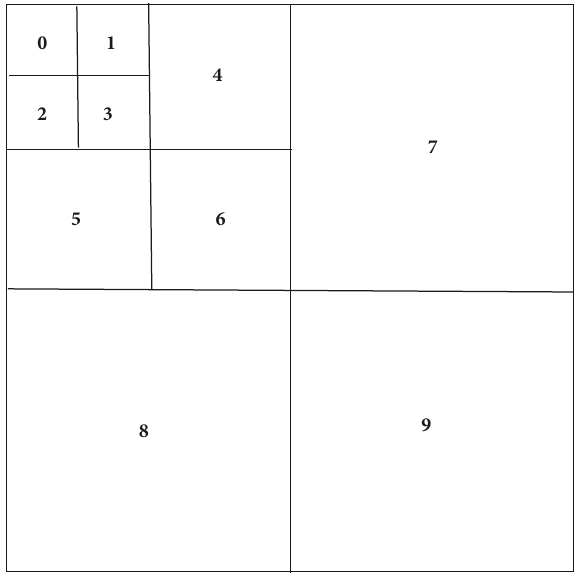
Figure 2: Ten subbands of Krawtchouk moments for one image block of 8 × 8 pixels.